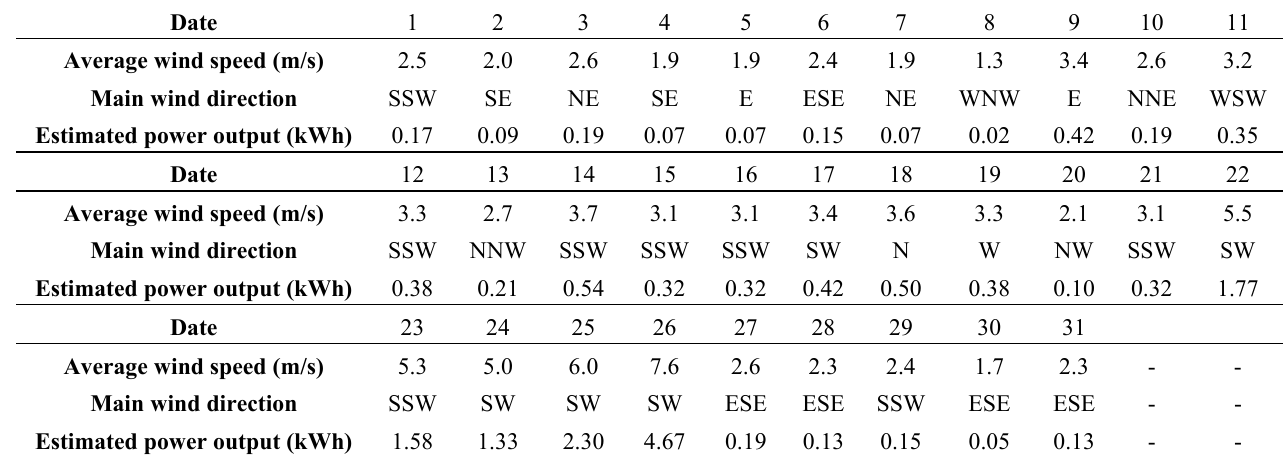
Table A7. Estimated power output per day in July.